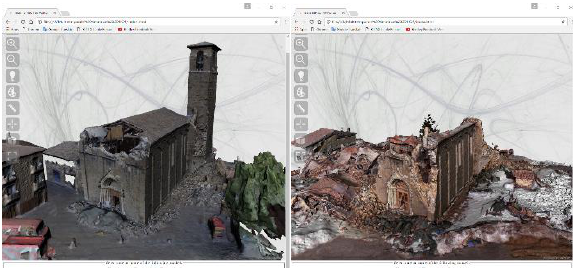
Figure 18. The online 3D HOP visualizer of the multi-temporal model (left, September; right,